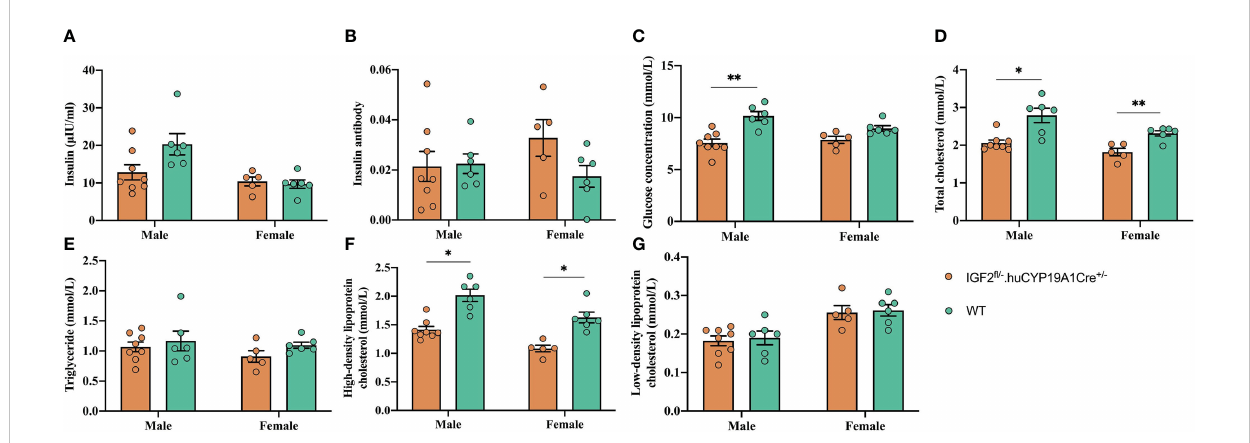
FIGURE 3 Effect of IGF2 overexpression on glycolipid metabolism in adult mice. The insulin (A) , insulin antibody (B) , glucose concentration (C) , total cholesterol (D) , triglyceride (E) , high-density lipoprotein cholesterol (F) and low-density lipoprotein cholesterol (G) levels of adult IGF2 fl /- . huCYP19A1Cre +/- and WT mice; n=5-8 mice in each group. * P < 0.05; ** P <